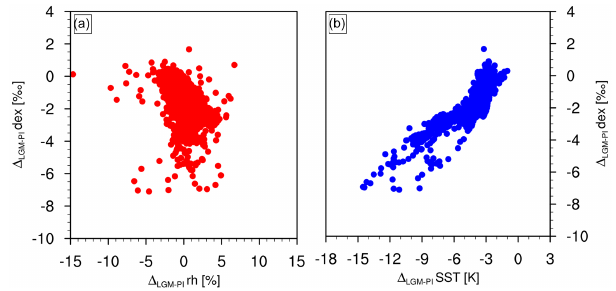
Figure 14. Relation between simulated LGM-PI deuterium excess (dex) changes in Southern Hemisphere water vapour of the low- est atmospheric model layer above the ocean surface vs. simulated LGM-PI changes in (a) relative humidity above the Southern Hemi- sphere ocean surface (RH, red symbols); (b) Southern Hemisphere sea surface temperatures (SSTs, blue